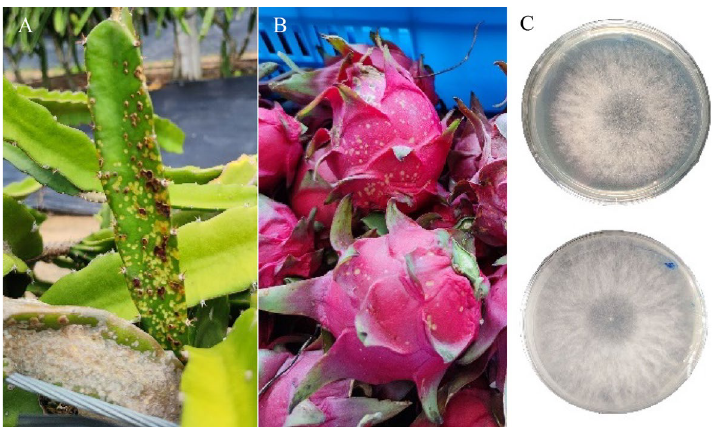
Figure 5. ( A ) Diseased stems in a field plantation; ( B ) diseased pitaya fruits; ( C ) morphological characteristics of N.